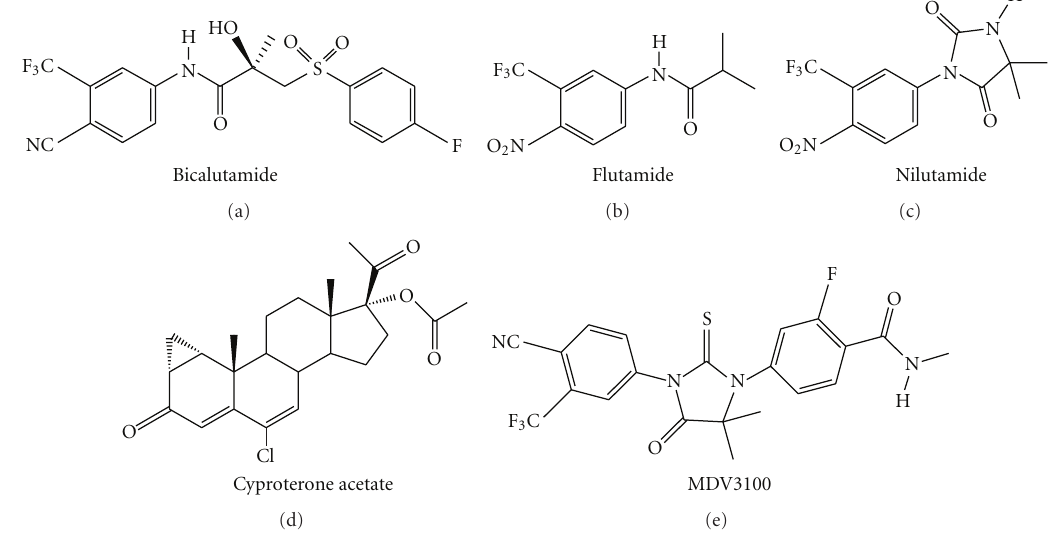
Figure 4: Structures of currently used antiandrogens and clinical candidate MDV3100. Table 1: Agents targeting AR in clinical development for CRPC.